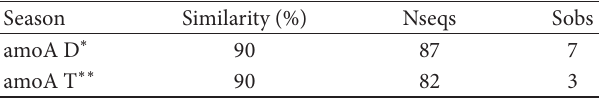
Table 4: 𝛼 -Diversity analysis for the amoA gene